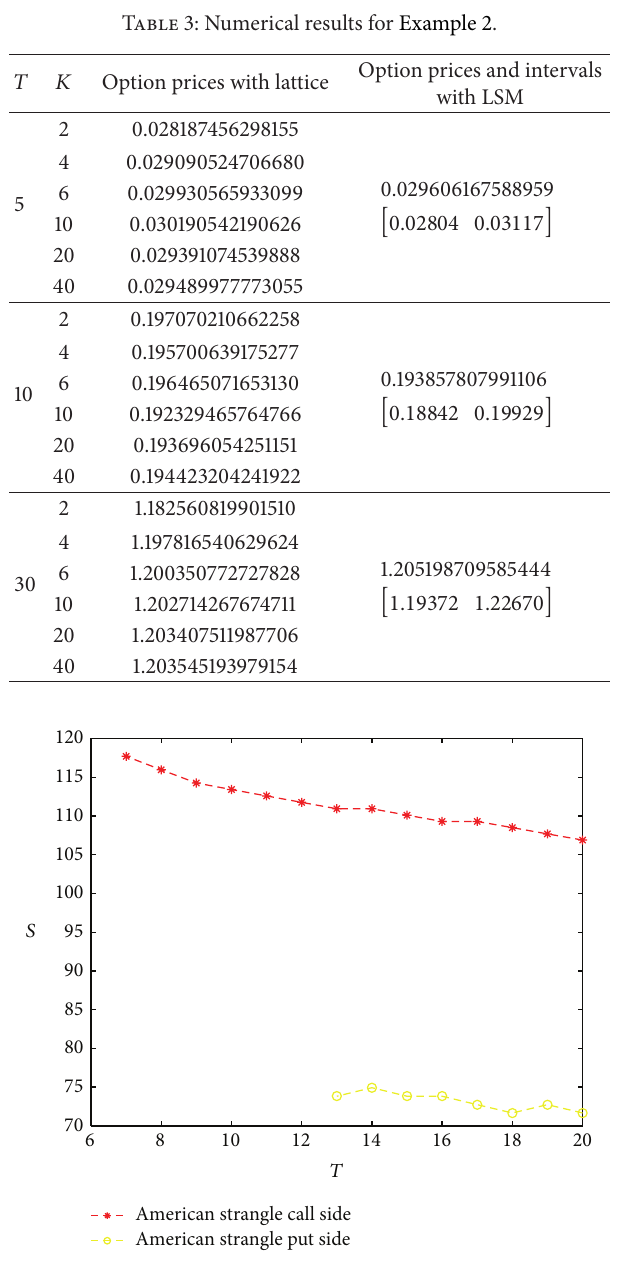
Figure 2: Optimal exercise boundaries for Example 3.